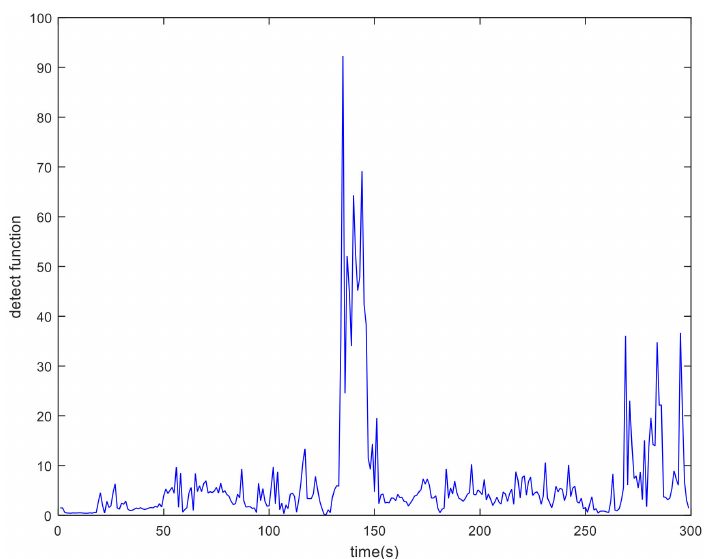
Figure 12. The test statistic of fault detection obtained by the dataset UrbanNav-HK